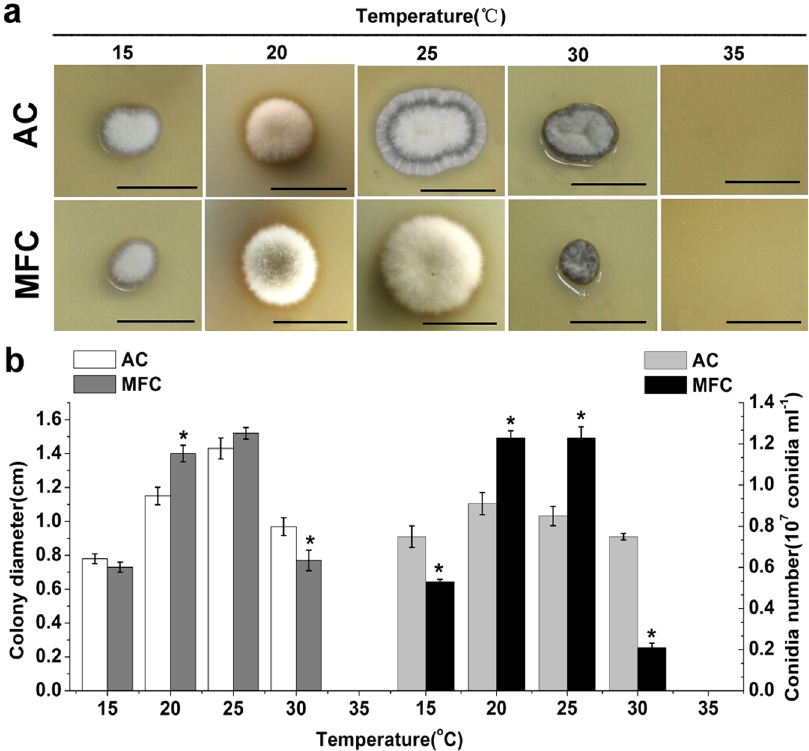
Figure 2. The heat tolerance experiment of two spores from Hirsutella satumaensis . ( a ) Colonial morphology of two spores at different temperature ranging from 15 to 30 °C. At 15 °C and 30 °C, colony diameter of MFC is smaller than AC, but which is no difference at 20 °C and 25 °C. Bar = 1 cm. ( b ) Statistics of two spores colony diameter and conidiation at different temperature. Analogously, the results of conidiation were consistent with the colony diameter. Statistical analysis was performed using a one-way ANOVA. Error bars are standard deviations of three trials and panels are representative of at least 2 independent experiments, * p <